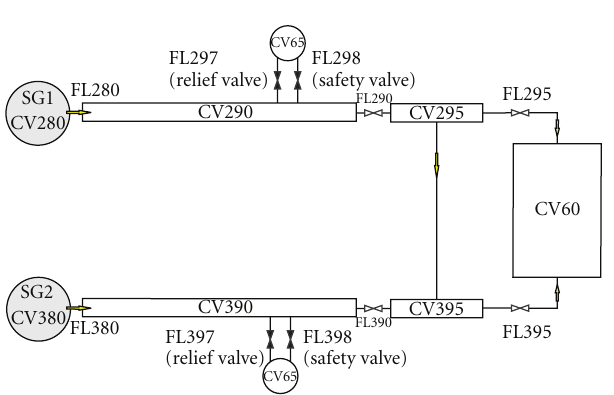
Figure 7: MELCOR nodalisation scheme of steam